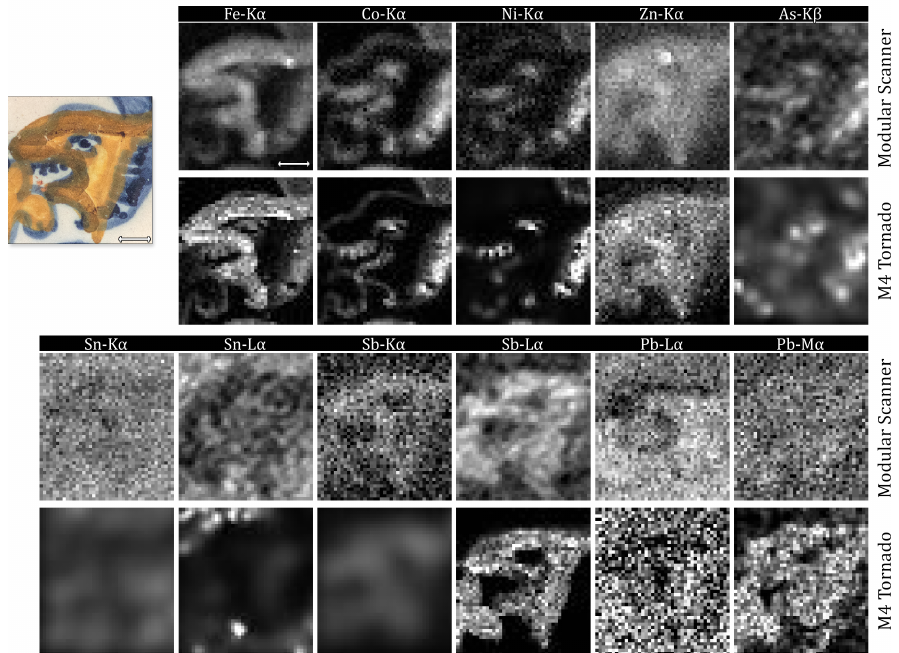
Figure 3. Elemental distribution maps obtained with the Modular Scanner and the M4 Tornado. Scale is 10